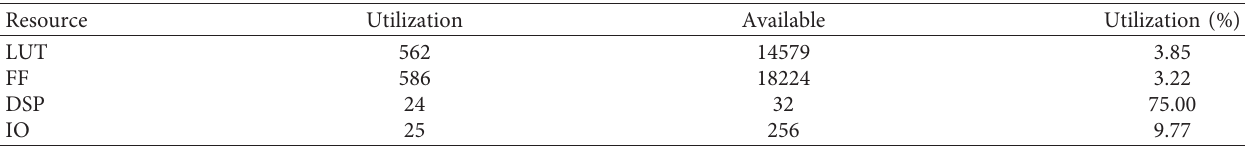
Table 2: Resource utilization rate of the filter